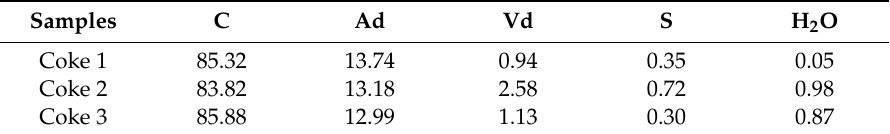
Table 3. The chemical composition of coke samples (wt%).